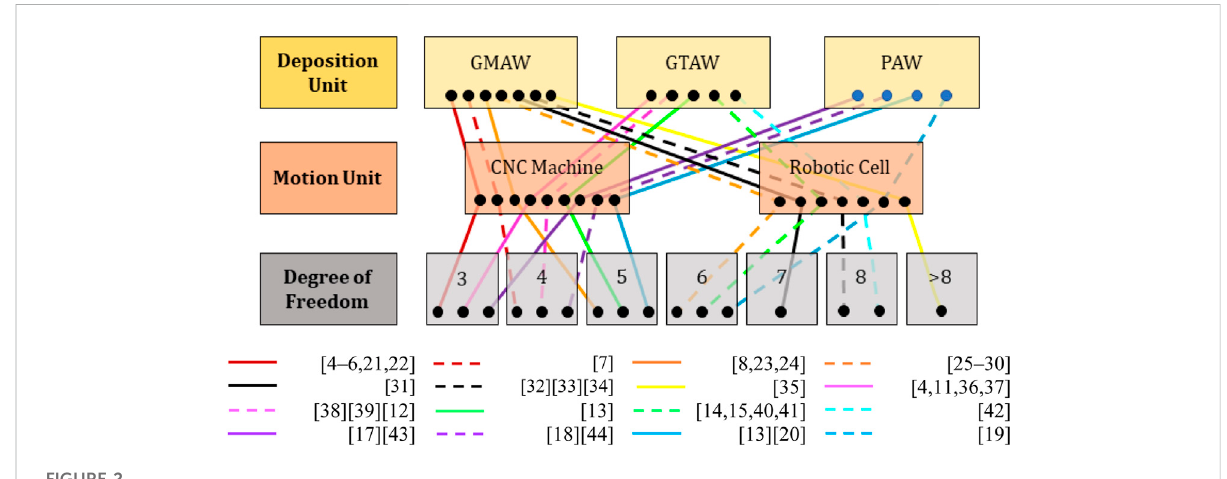
FIGURE 2 Classi fi cation of WAAM setups.